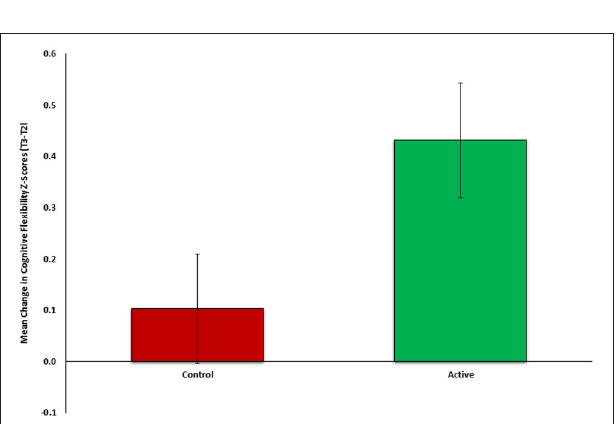
FIGURE 2 | Mean change in cognitive flexibility after intervention (T2-Tl) between active ( n = 26, green) and control ( n = 27, red) groups of Study 2.